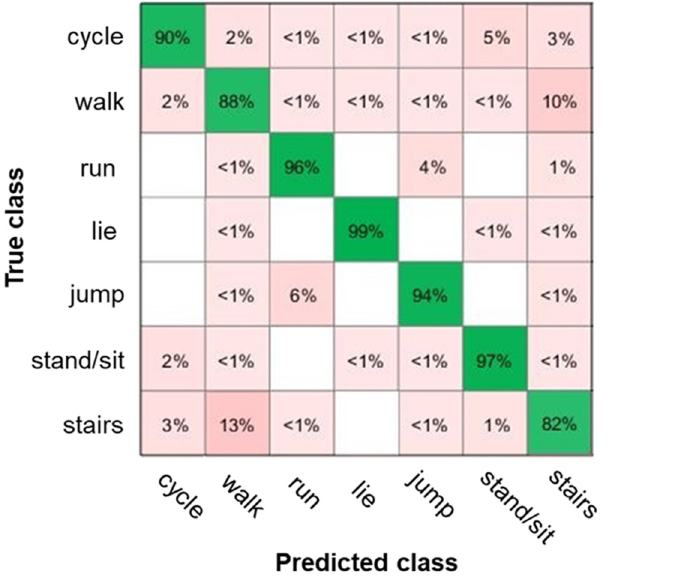
Fig 8. Confusion matrix for the cubic SVM classifier with 13 features.